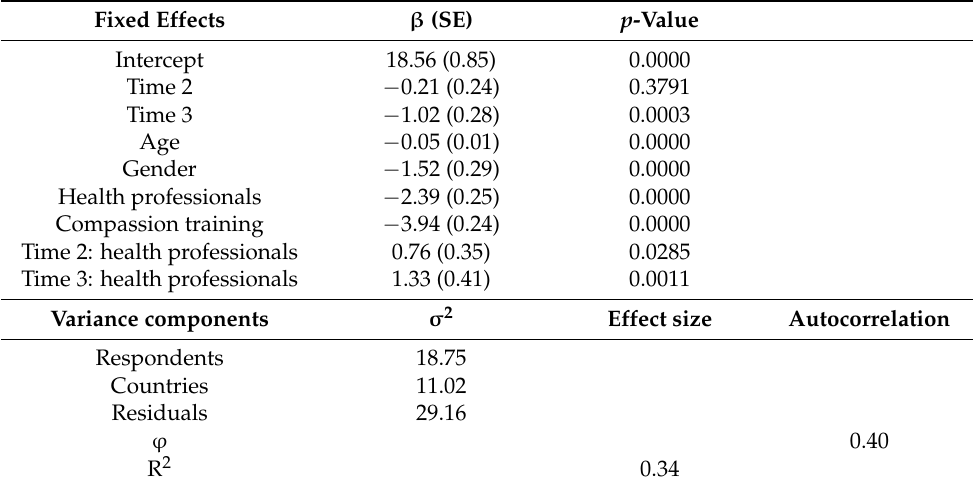
Table 5. Estimates of the final model for fears of compassion for others.